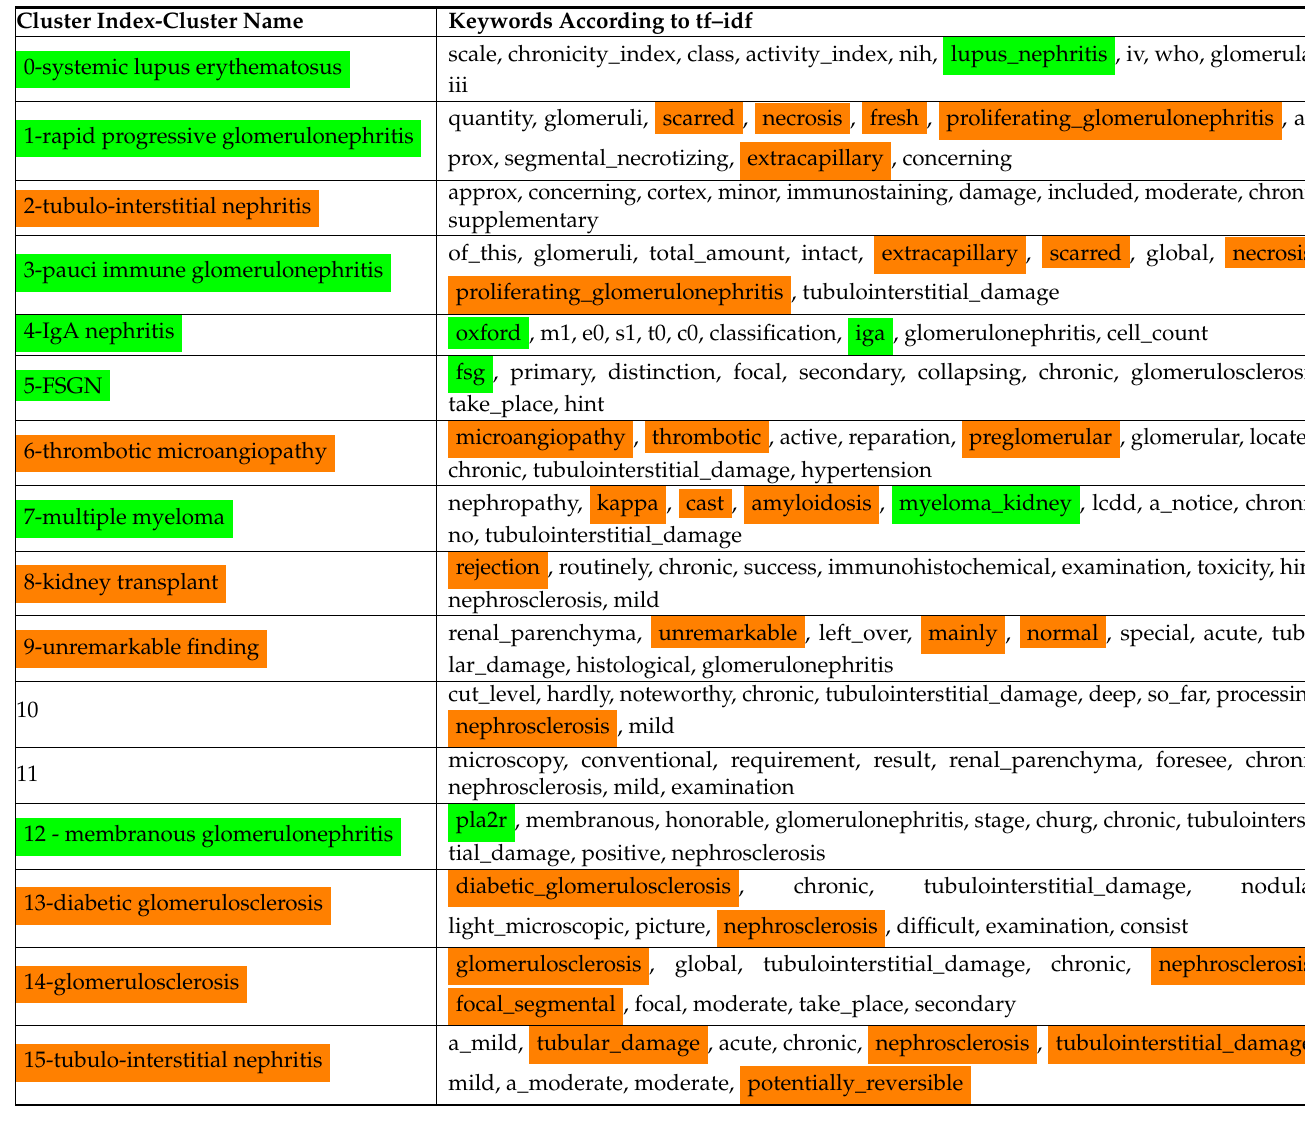
Table 2. Annotated topic words (translated from German to English), extracted from the HDBSCAN! ( HDBSCAN! ) cluster-set, using the tf–idf based extraction method. A particularly large number of topic words strongly refer to cluster names (left column) highlighted in green (strong cluster names). In the case of cluster names marked in orange, only a few topic words indicated the specified cluster name (weak cluster name). The same applies to the colour-coded topic words: topic words that strongly indicate a cluster name are highlighted in green (strong topic words). Orange highlighted topic words only weakly indicate a cluster name (weak topic